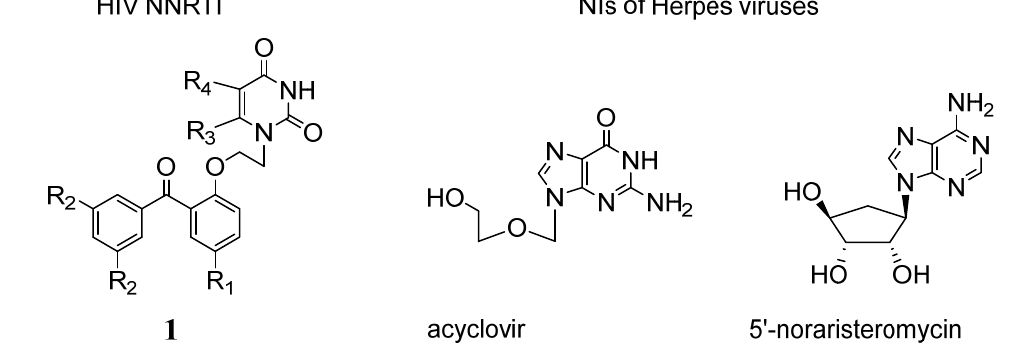
Figure 1. Lead antiviral agents.